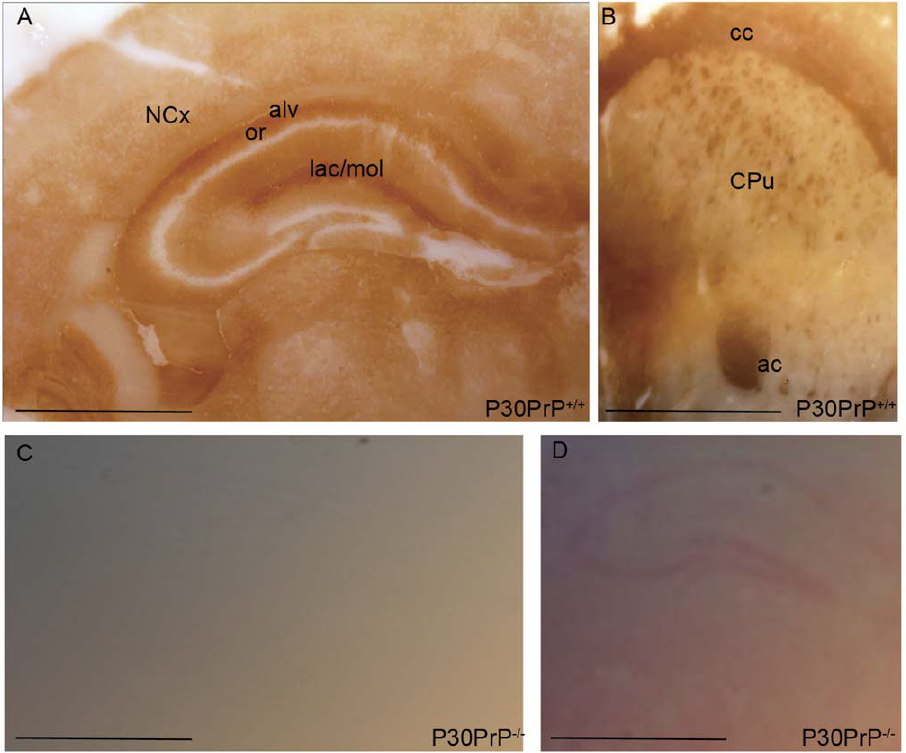
Figure 6. Localization of PrP C in P30 MoPrP + / + brain and control of signal specificity. (A) At P30 a well-defined signal was present in the hippocampal stratum lacunosum-moleculare layer (lac/mol) and in the alveus (alv) lying just deep to the stratum oriens layer (or). (B) In the septum- caudatum, PrP C signal was detected predominantly in white matter fiber bundles, such as the anterior commissure (ac) and the corpus callosum (cc). The dark dots observed in the caudate-putamen (CPu) are fiber fascicles cut on end. (C) At P30, the lack of IR in MoPrP 2 / 2 coronal section confirmed the signal specificity. (D) The presence of the brain section on the nitrocellulose membrane was confirmed by Ponceau staining. (Bars: A–D 0.5 mm).